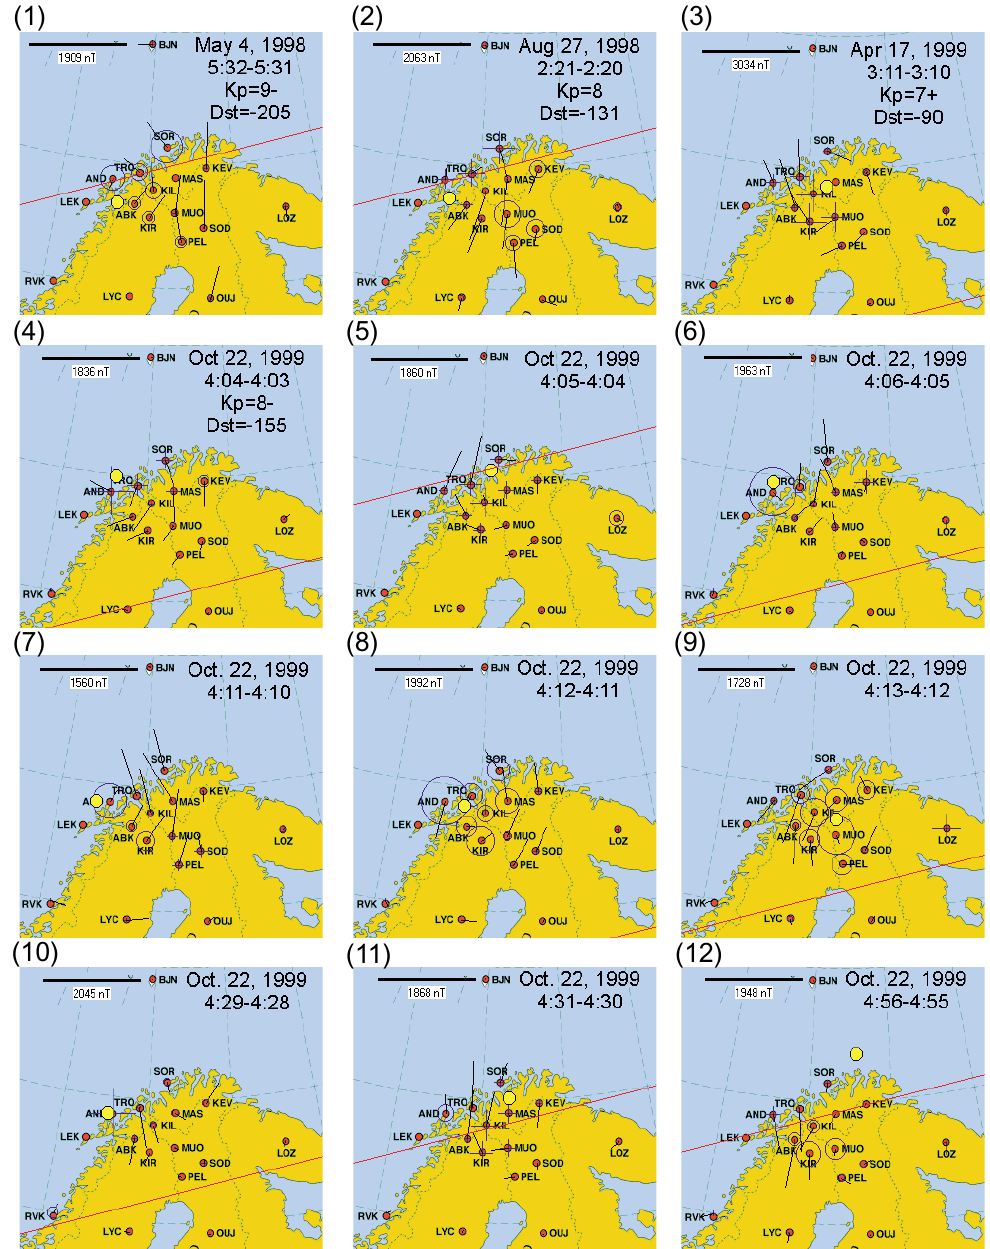
Fig. 3. Differential equivalent current patterns for ten strongest dB/dt events in 1996-2000. One-minute differences of magnetic field values are shown. Arrows correspond to the horizontal magnetic field vector rotated 90 degrees clockwise, circles and crosses correspond to an upward and downward vertical component, respectively. The best fit model locations of the electrojet (red line) and the vortex (yellow circle) are also shown for comparison. Vortex-dominated pattern is distinctly seen in most cases. The samples 7 and 9 were added to illustrate the